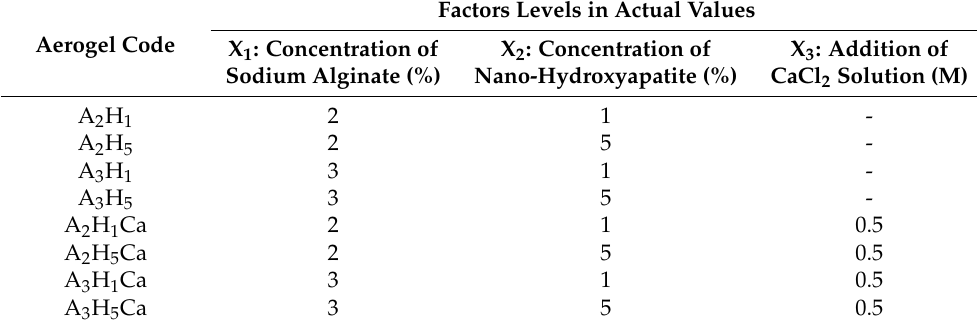
Table 2. Compositions of the prepared alginate/nano-hydroxyapatite composite aerogels loaded with tranexamic